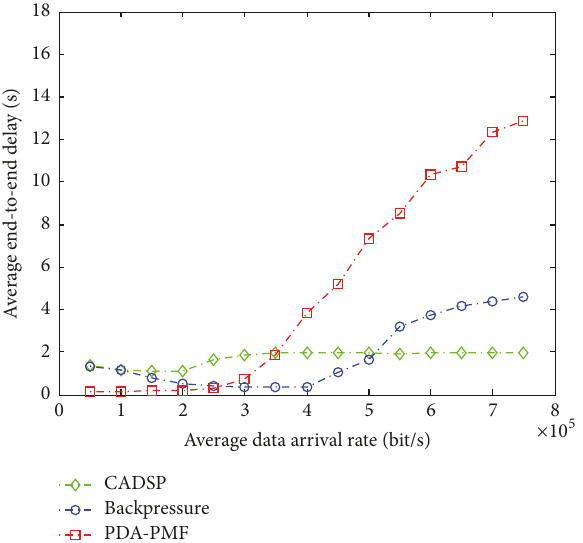
Figure 5: Comparison of average end-to-end delay of service 2 in multihop network.